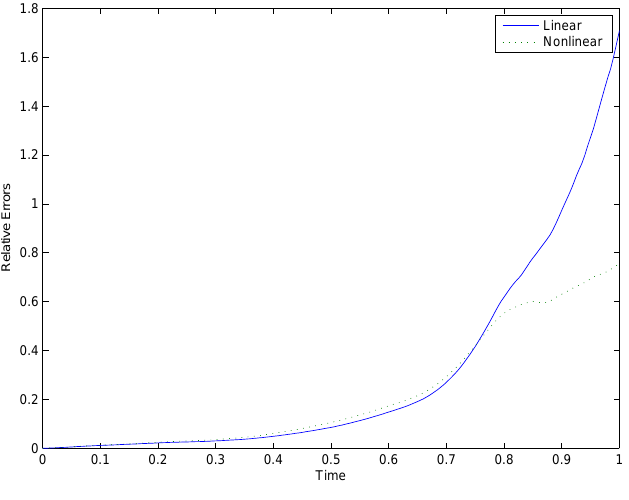
Figure 7. Comparison of the relative L 2